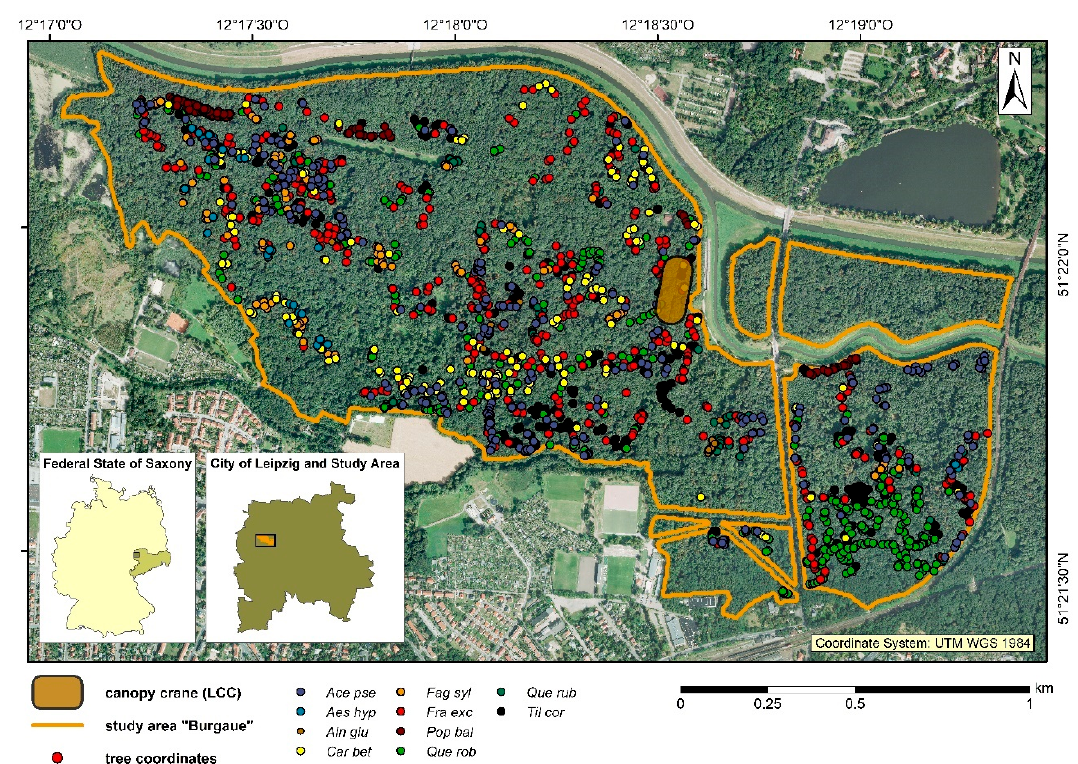
Figure 1. Location of Leipzig’s Canopy Crane (orange polygon) and tree locations (dots) of forest inventory data within the borders of the study site Burgaue (orange line). Tree species identities are color-coded.